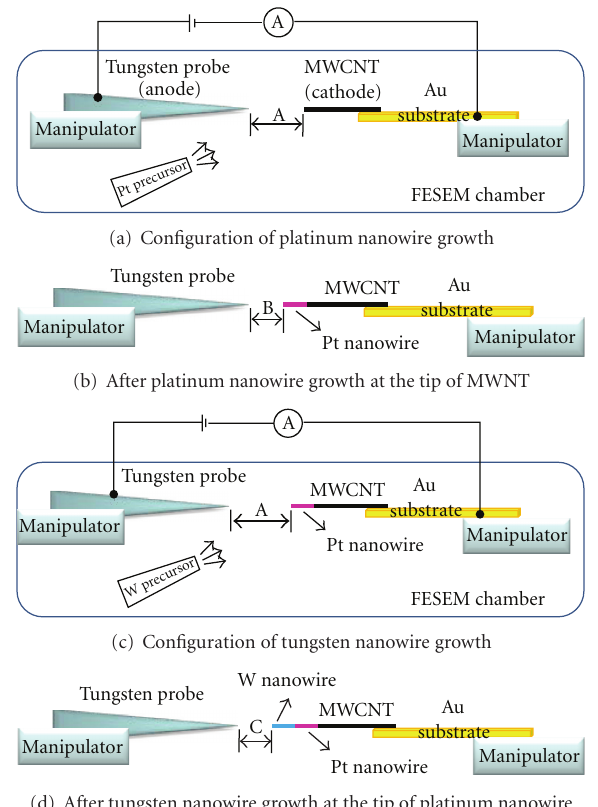
Figure 2: Schematic showing the apparatus configuration during hybrid nanowire growth: (a) configuration of platinum nanowire growth, (b) after platinum nanowire growth at the MWCNT tip, (c) configuration of tungsten nanowire growth, and (d) after tungsten nanowire growth at the tip of platinum nanowire.